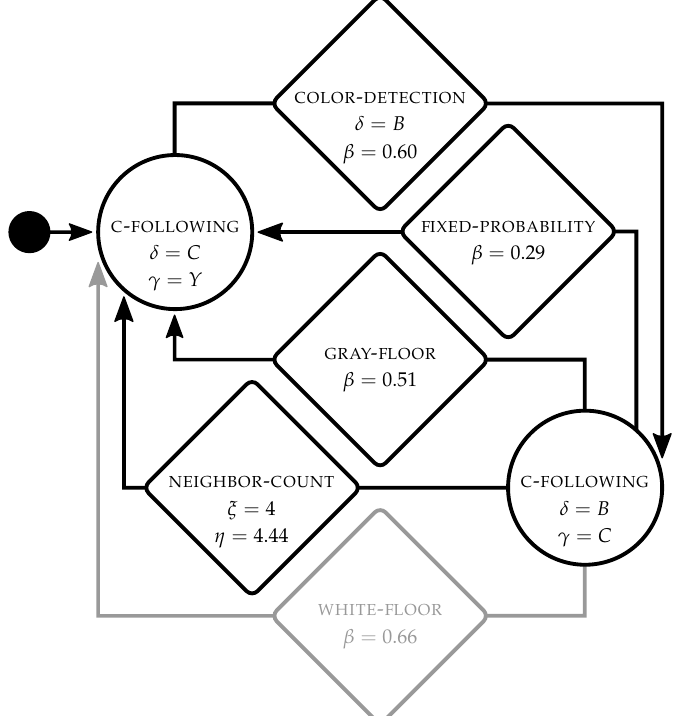
Figure 5. Instance of control software produced by TuttiFrutti for AGGREGATION . The probabilistic finite state machine shows the effective modules in black and non-reachable modules in light gray. Circular modules represent the low-level behaviors and rhomboid modules represent the transition conditions. Modules labeled as C - FOLLOWING stand for the low-level behavior COLOR - FOLLOWING